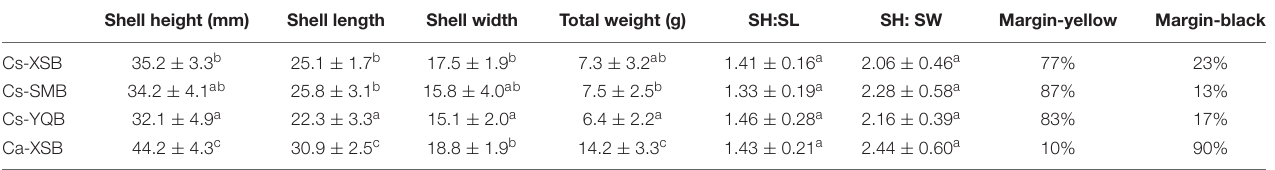
Cs-XSB, Crassostrea sikamea sampled in Xiangshan bay; Cs-SMB, Crassostrea sikamea sampled in Sanmen bay; Cs-YQB, Crassostrea sikamea sampled in Yueqing bay; Ca-XSB, Crassostrea angulata sampled in Xiangshan bay. Different letters mean that production performances of populations of Kumamoto oyster and Portuguese oyster are significantly